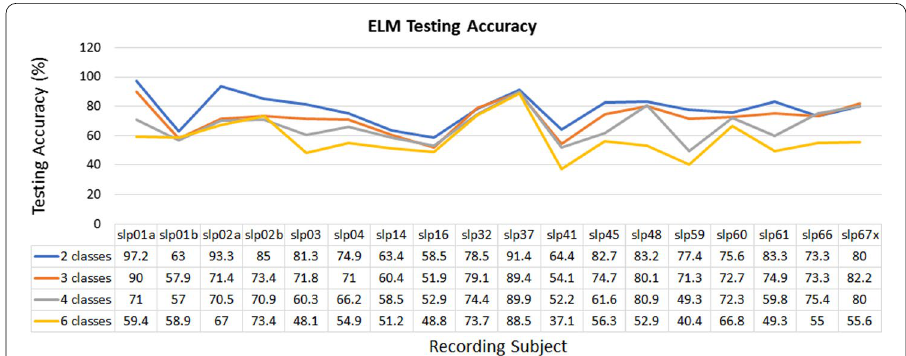
Fig. 3 The testing accuracy of ELM algorithm in 4 sets of classes